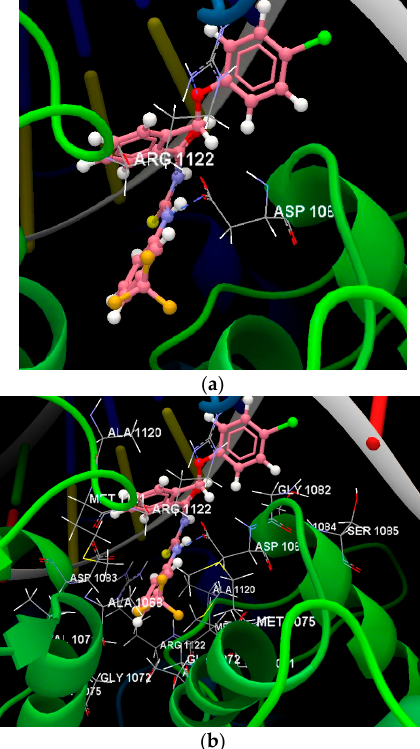
Figure 7. ( a ) The hydrogen bonds between the amino acid residues of the ASP 1083(D), ARG 1122(B) and the compound 1f was displayed in dashed blue lines. ( b ) Docking pose of the 1f ligand interacting with amino acids residues. Processes 2020 , 8 , x FOR PEER REVIEW